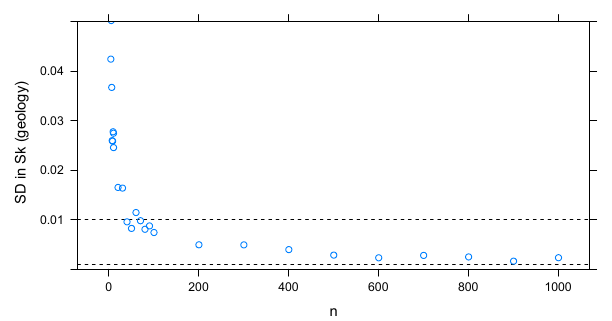
Figure 3. Standard deviation of calculated S k showing convergence characteristics as a function of sample size. Calculated by resam- pling and subsampling a single ensemble 10 times for each subsam- ple n . Decreasing standard deviation demonstrates convergence on a solution. Dashed lines represent a standard deviation in S k of 0.01 and